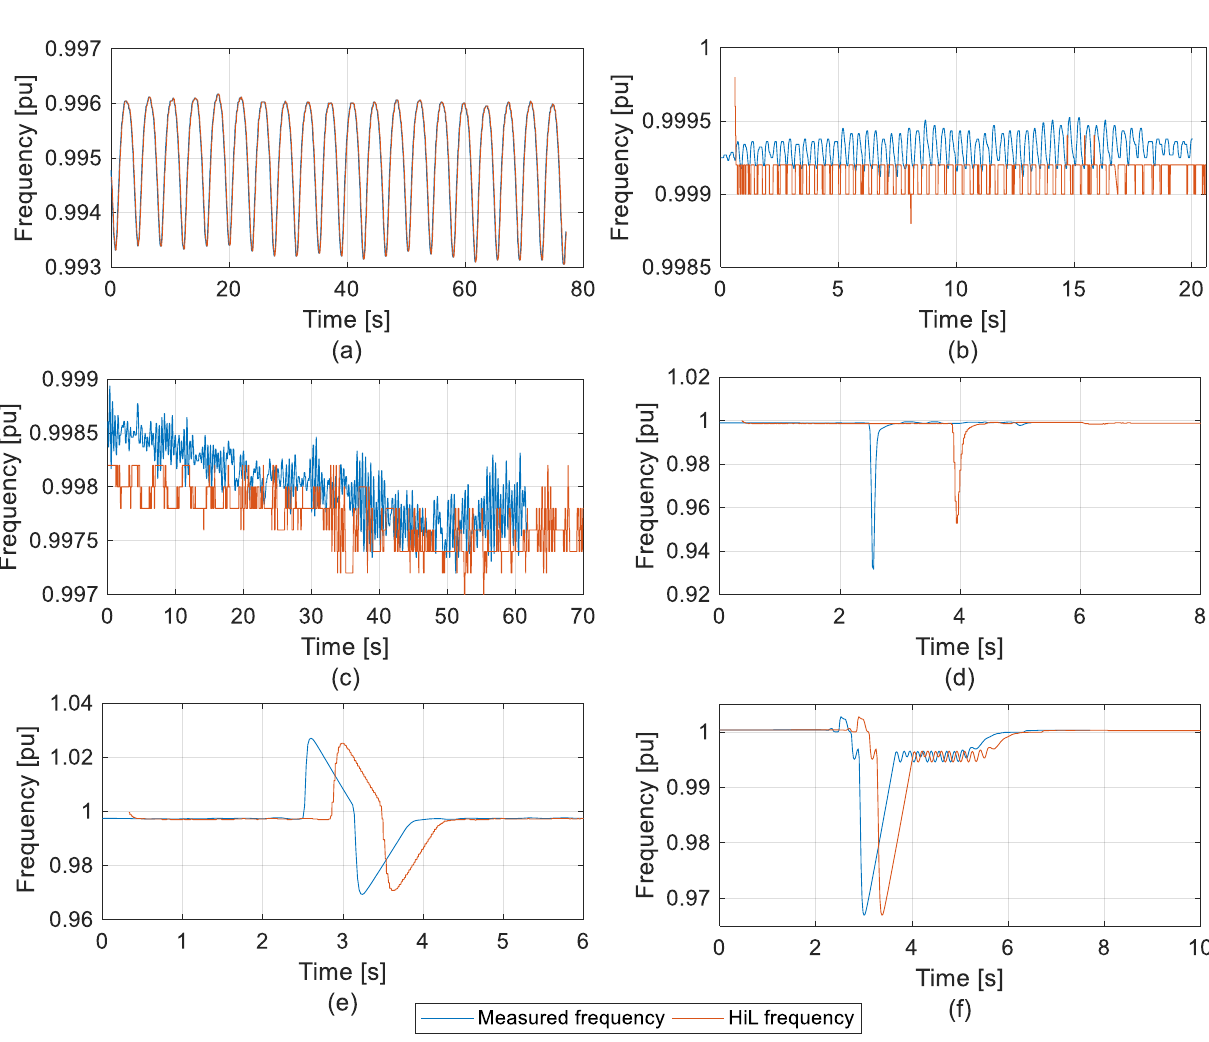
Figure 8. Comparison of the normalized measured frequency (blue) with the normalized frequency modelled in the hardware-in-the-loop test (orange) for scenario 1 ( a ), scenario 2 ( b ), scenario 4 ( c ), scenario 7 ( d ), scenario 8 ( e ), and scenario 10 ( f